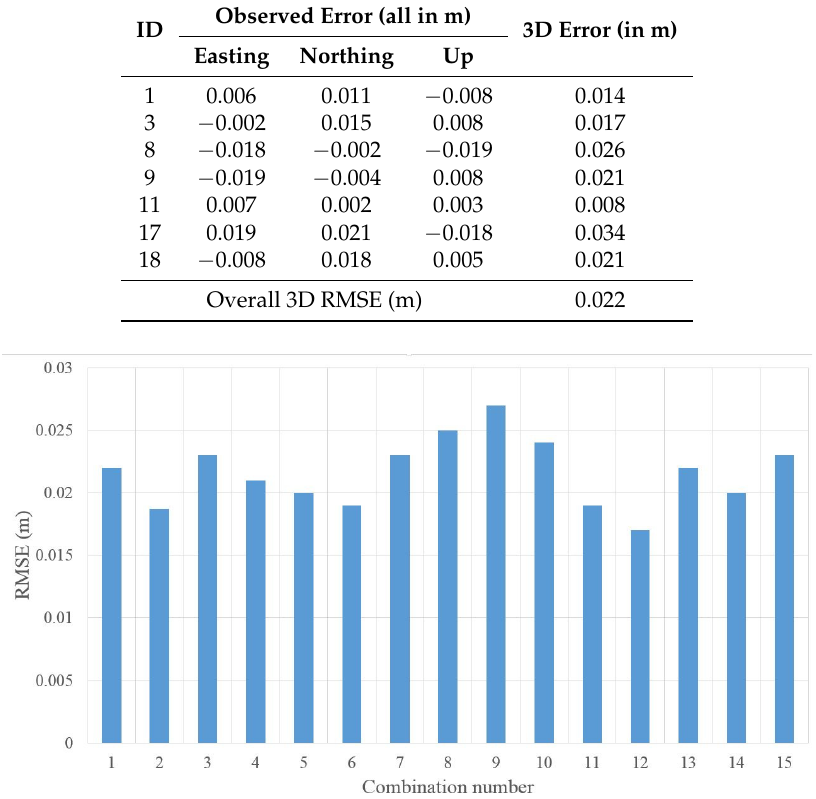
Figure 16. A plot of RMSE obtained for different combinations of check points and control points.